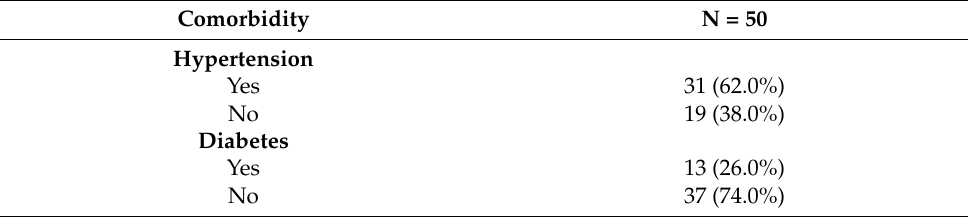
Table 2. Data on